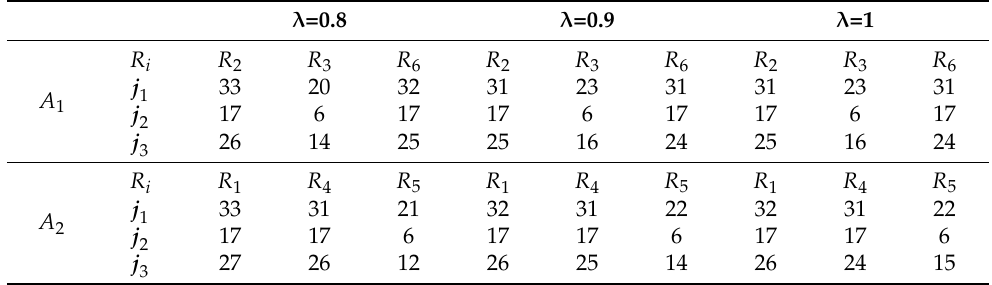
Table 8. Optimal decision-making quantities under different confidence levels in an extraordinarily serious accident q 1 .